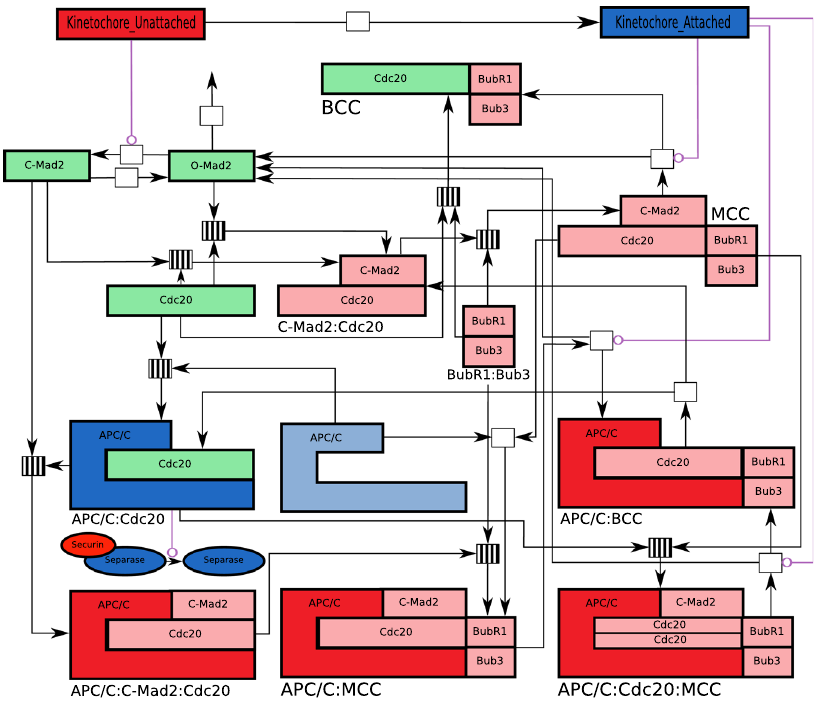
Figure 2. The reaction network in our model. The names of the basic species are shown in colored boxes. Molecule names are below the corresponding complexes, which are composed of basic building blocks. White boxes represent irreversible reactions, and striped boxes represent reversible reactions. In both cases, ingoing arrows are educts and outgoing arrows are products (of the corresponding forward reactions). Red boxes contain species with inhibitory functions, blue boxes contain species that promote and initiate anaphase, and green boxes contain species with non-strict functions. Purple lines show catalytic effects on the corresponding